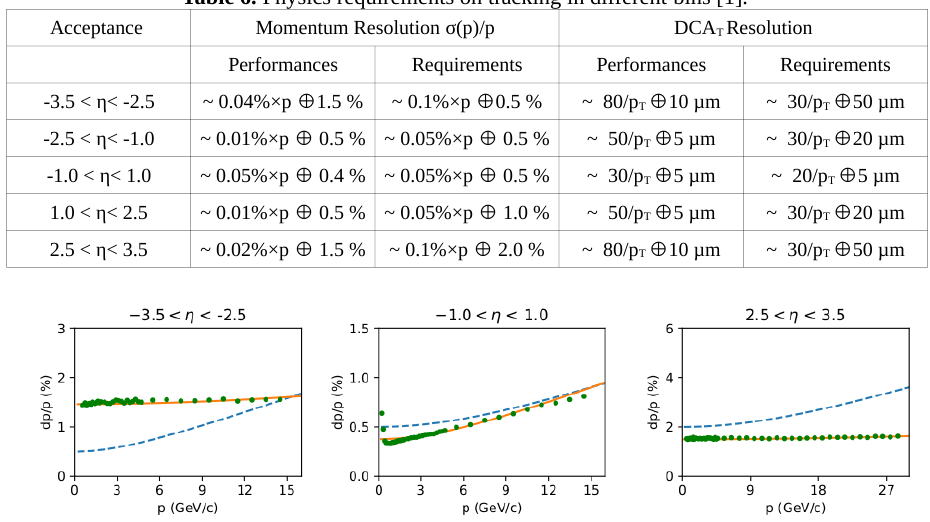
Fig. 3. Momentum resolutions versus momentum for the ATHENA setup corresponding to simulated pions- uniform in η momentum compared to the physics requirements in YR for selected η bins [7].